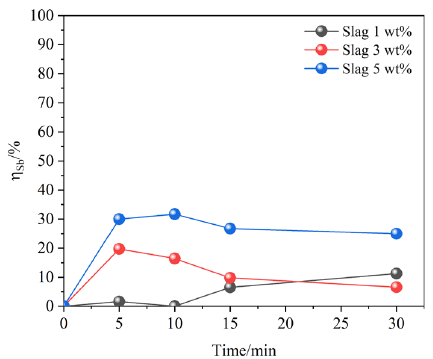
Figure 2. Effect of slag quantity on Sb removal ratio at T = 1873 K, initial Sb = 0.06 wt%, initial C content = 0.05 wt%, and initial CaC 2 = 20 wt%.